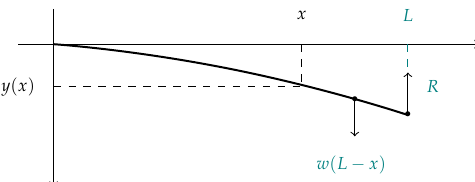
Figure 6. Beam with one end fixed and the other with a force R opposite to the deflection.